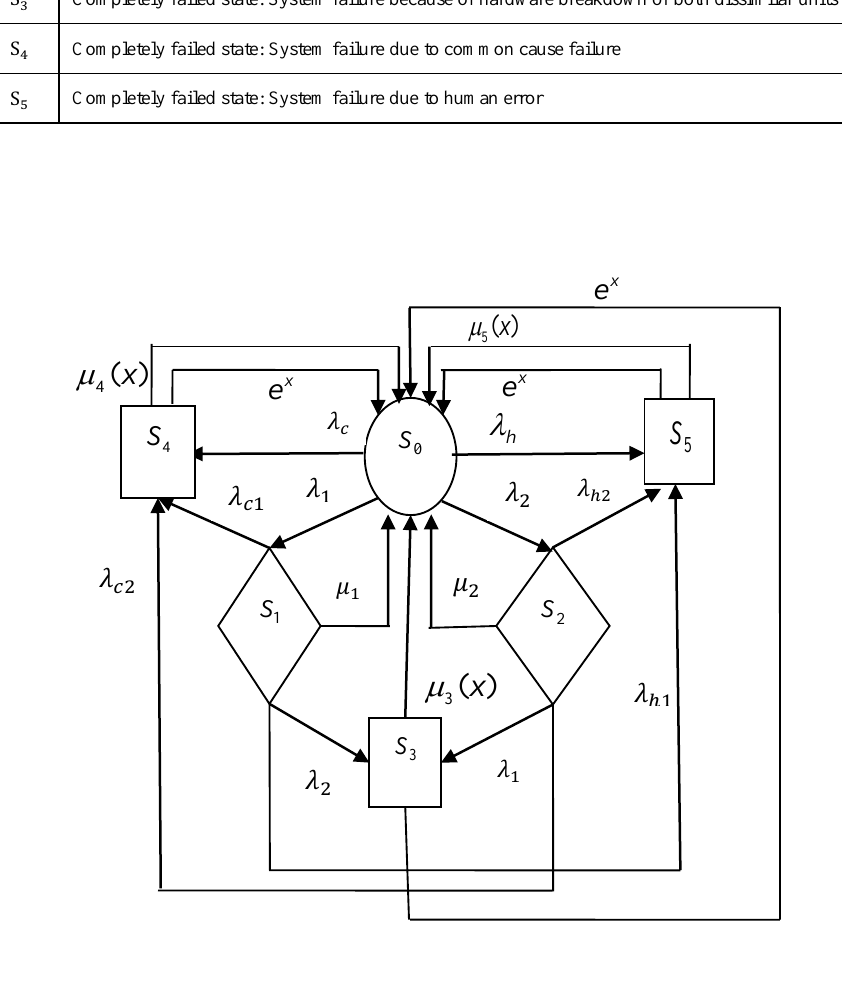
Figure 1. State transition